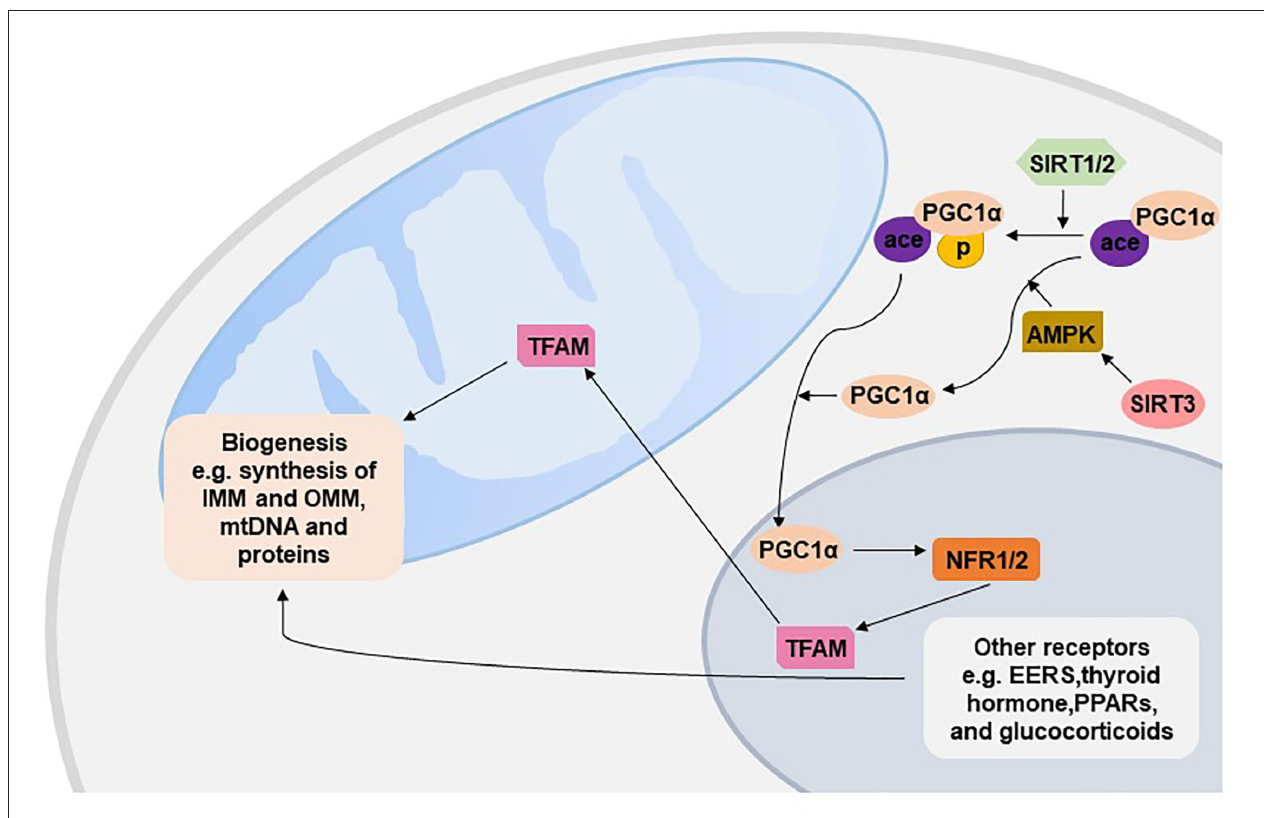
FIGURE 3 | Mitochondrial biogenesis. EERs, estrogen-related receptors; PPARs, peroxisome proliferator-activated receptors; TFAM, mitochondrial transcription factor A; PGC1 α , peroxisome proliferator-activated receptor gamma coactivator 1-alpha; NFR, nuclear respiratory factor; SIRT, Sirtuin; AMPK, AMP-activated kinase; IMM, inner membrane of the mitochondrion; OMM, outer membrane of the